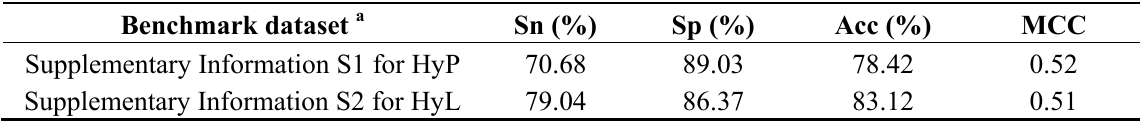
Table 2. The jackknife test results by the iHyd-PseAAC predictor on the benchmark datasets in Supplementary Information S3 and